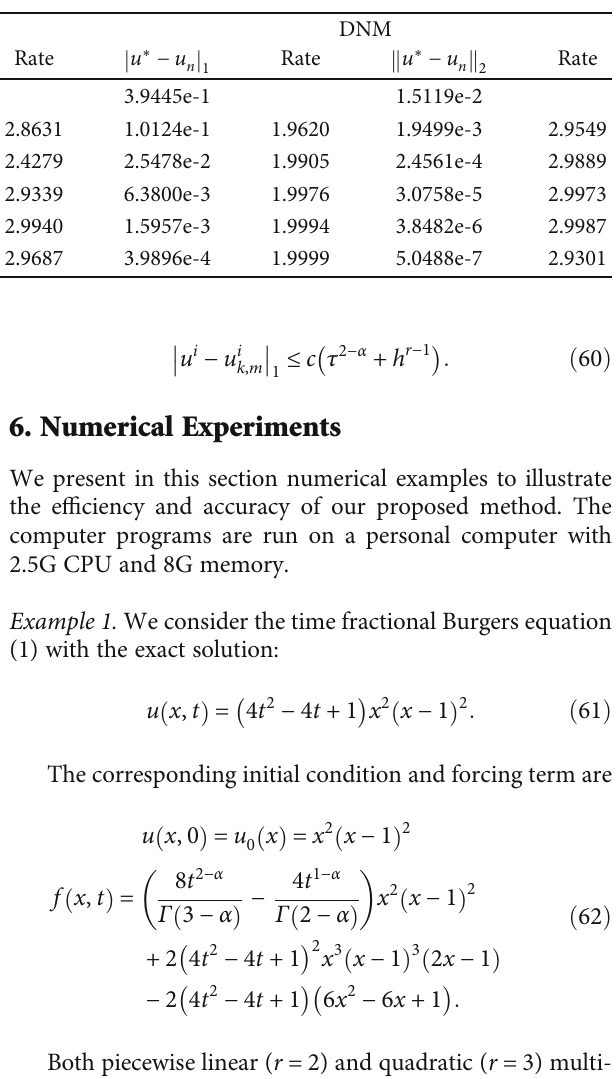
Table 8: Errors and convergent orders of MAM and DNM via quadratic basis in spatial direction with k = 2, τ = 0 : 005 , and α = 0 : 1 for Example 2.